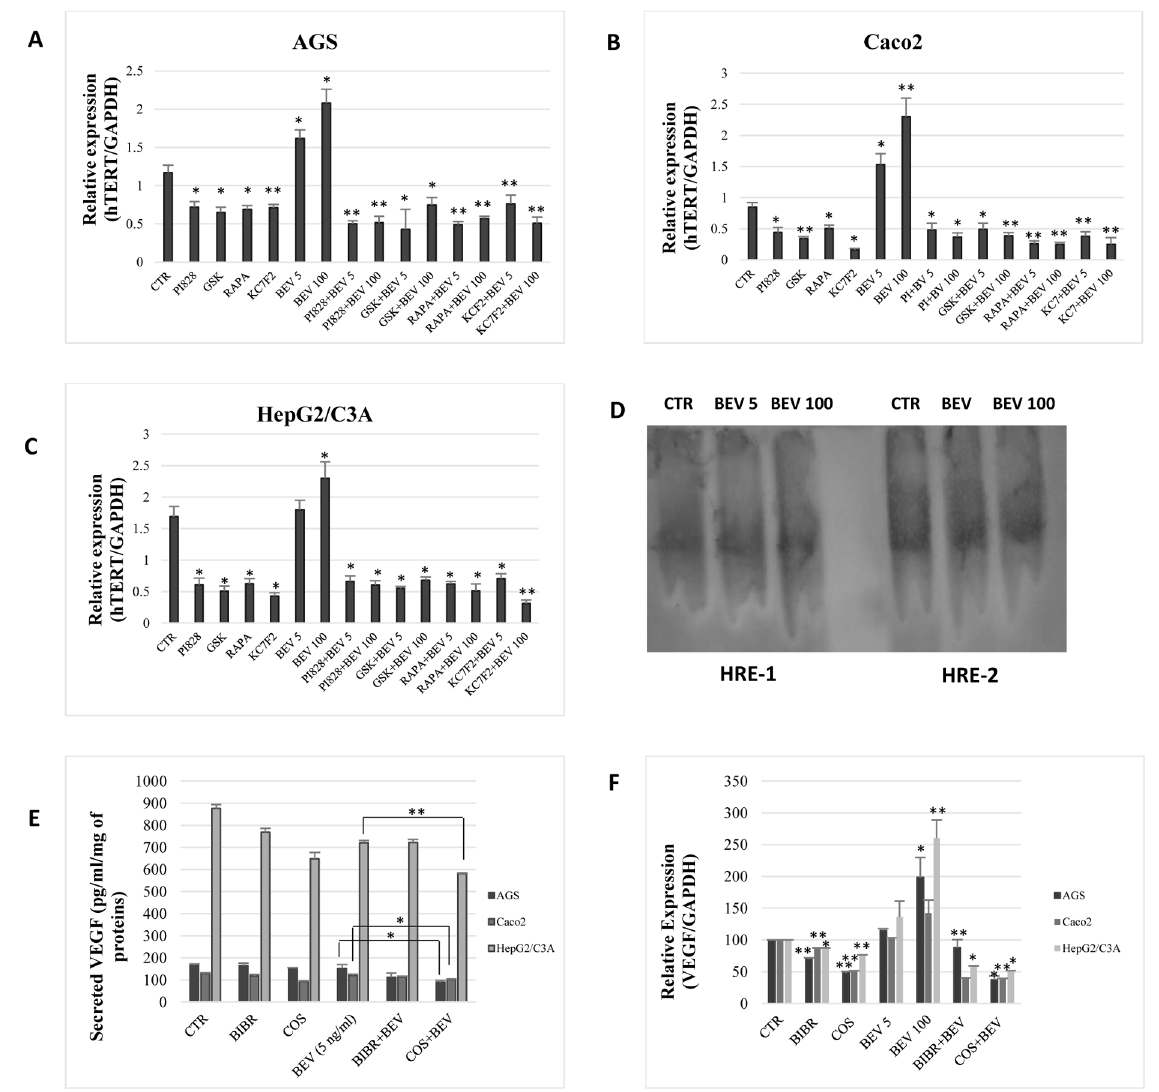
Fig 3. VEGF induces hTERT expression via PI3K/AKT/mTOR and HIF-1 α . AGS (A), Caco2 (B), and HepG2/C3A(C) were treated with PI 828 (10 μ M),GSK 690693(100nM), Rapamycin (200nM), and KC7F2 (40 μ M)with or without bevacizumab for 48 h. The amount of hTERT transcripts was quantifiedby real-time PCR. (D) EMSA was performed on nuclear cell extracts incubated with oligonucleotides of two HIF-1 α bindingsites, HRE-1 and HRE-2. (E) VEGF secretion was quantified with ELISA. (F) Total RNAs from the cells treated in (E) were collected,and the amount of hTERT transcripts was quantifiedby real-time PCR. Results were expressedas the mean ± SD from three